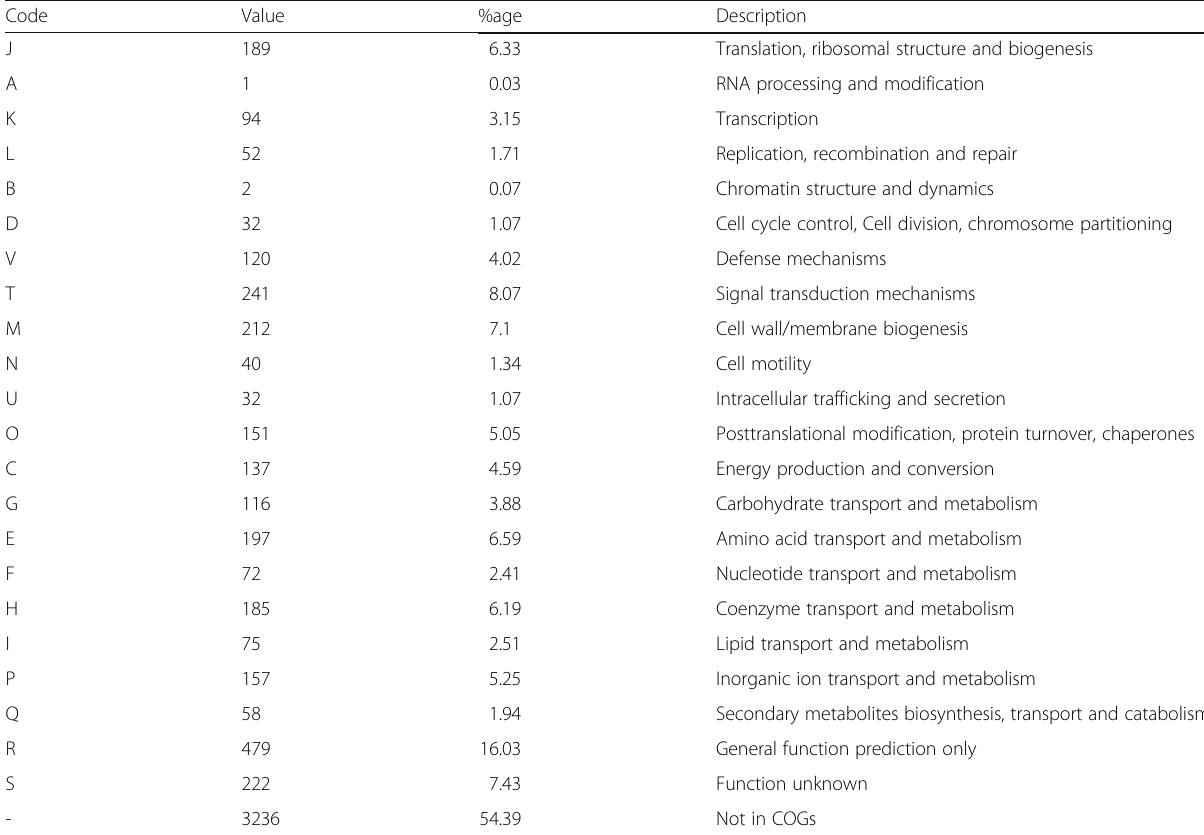
Table 4 Number of genes associated with general COG functional